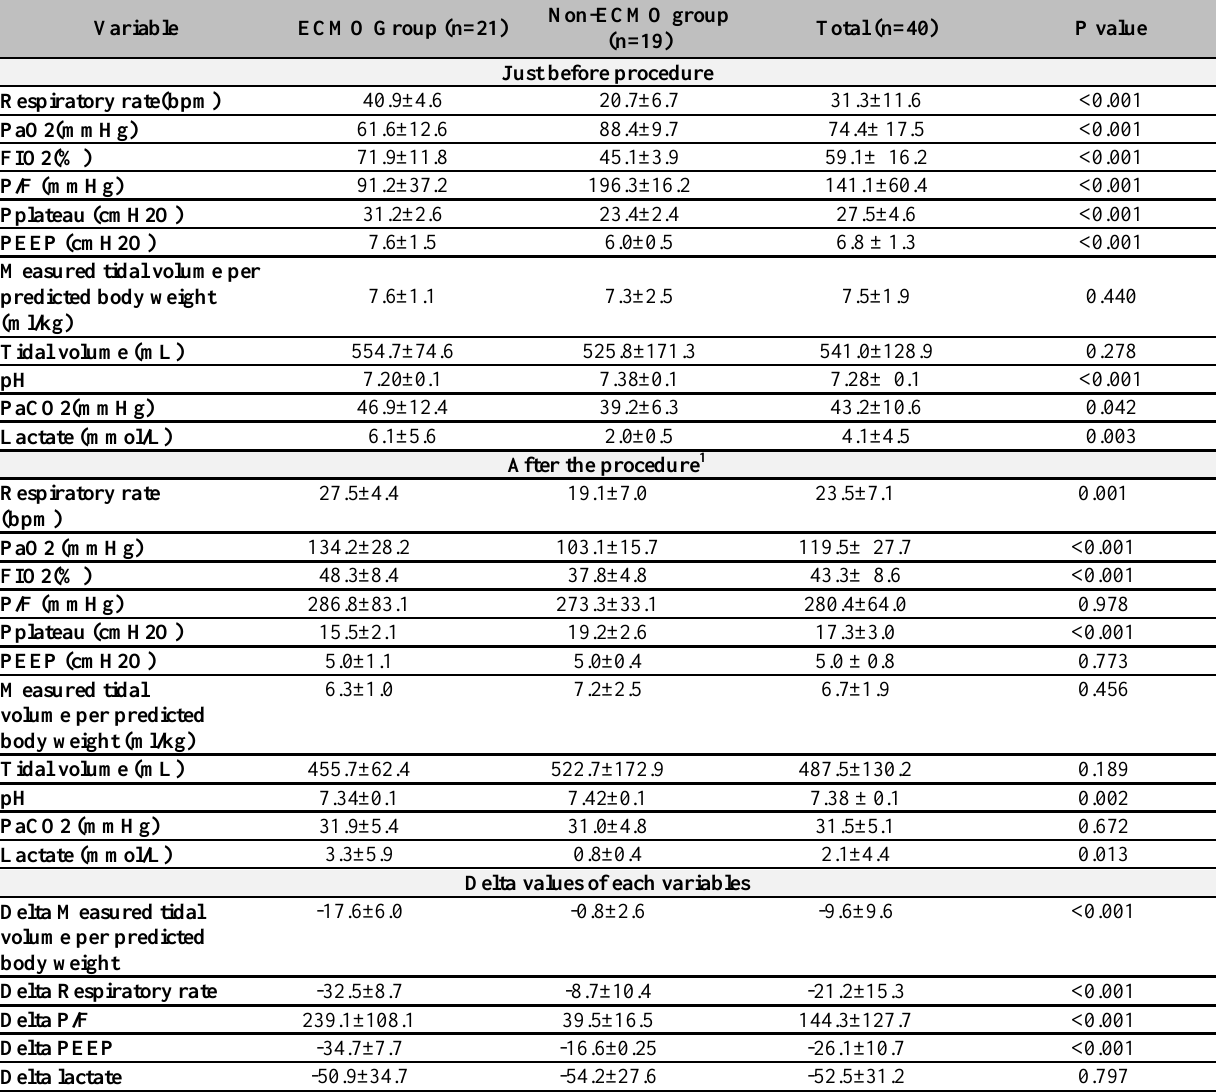
Table 2. Mechanical ventilator parameters and arterial blood gas analysis of